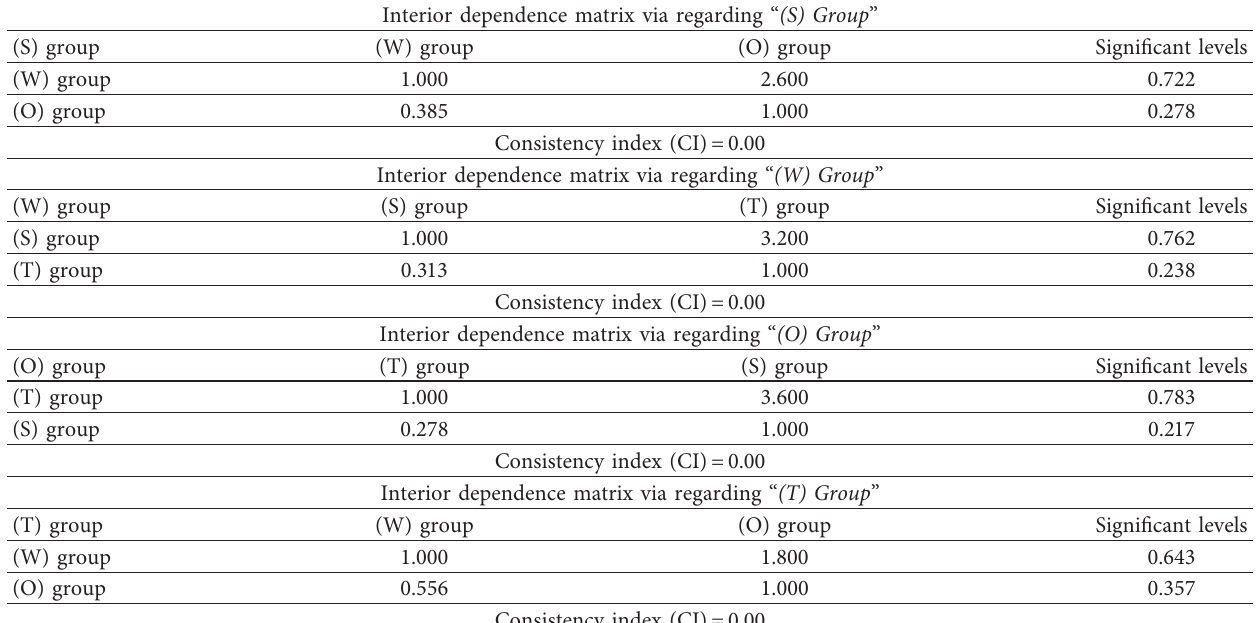
Table 10: Interior dependency matrix.